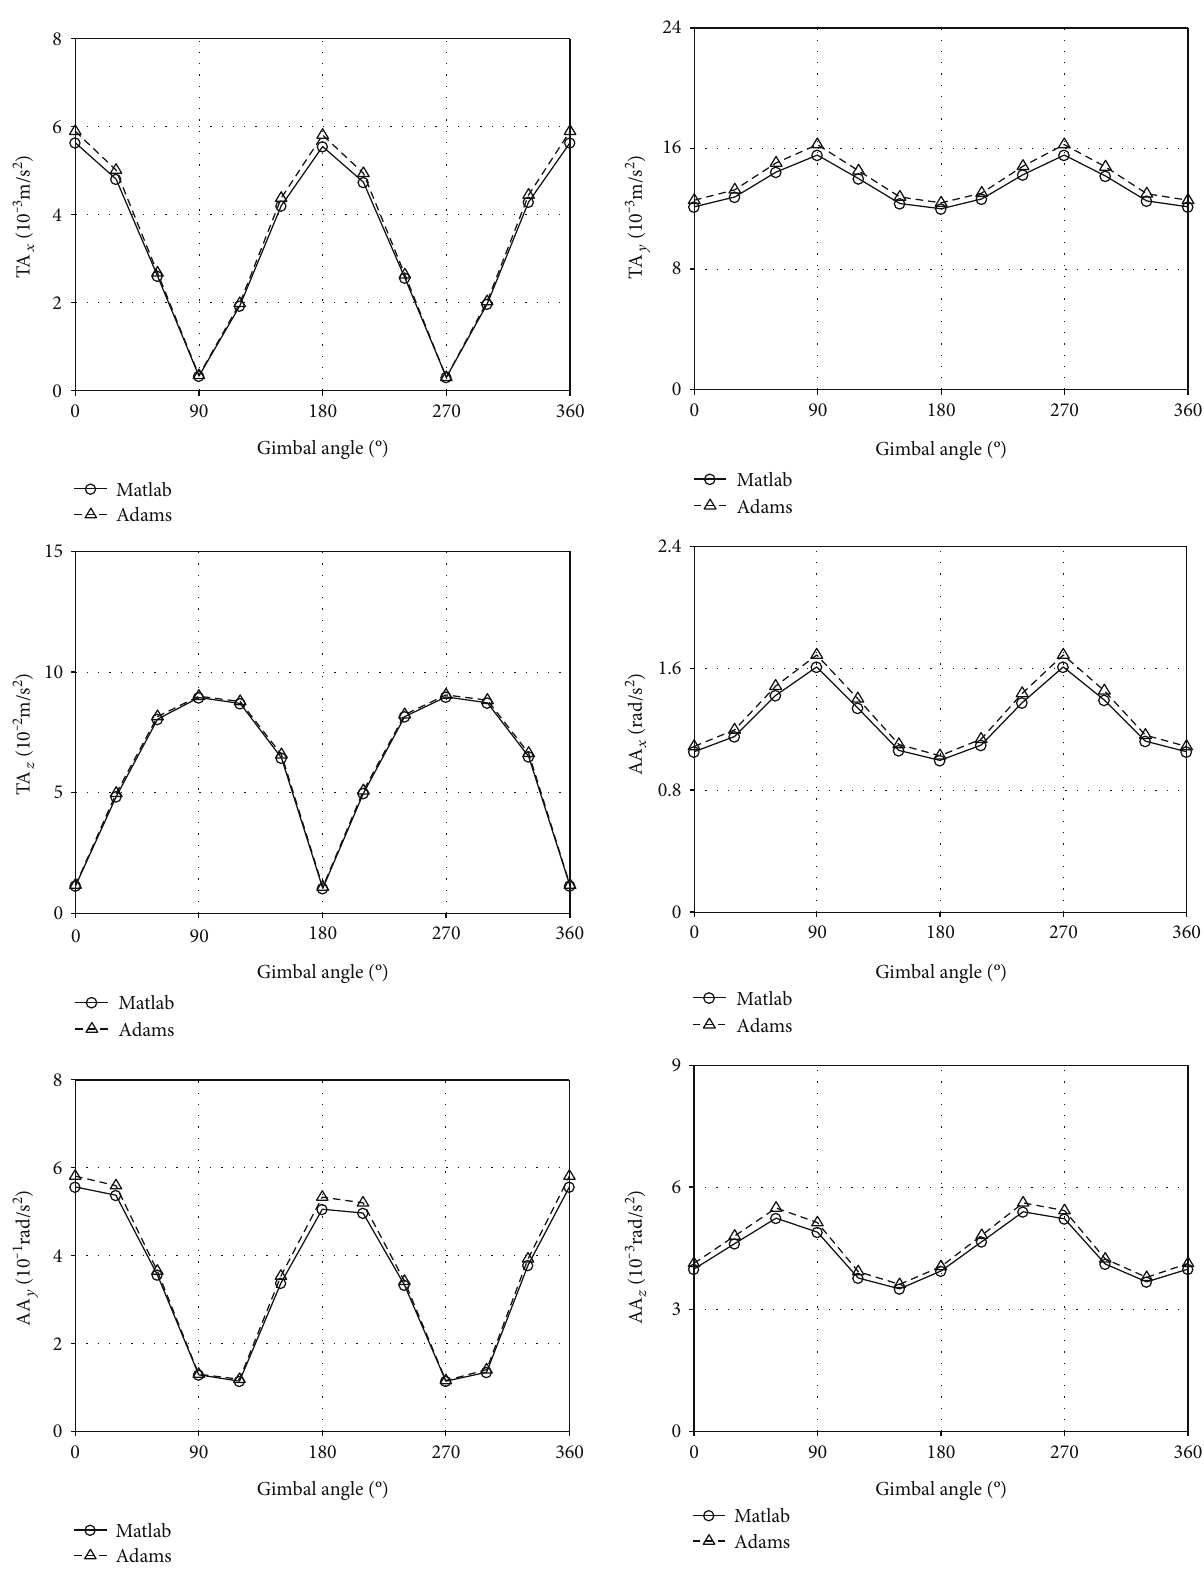
Figure 16: Translational and angular acceleration amplitude by MATLAB and Adams